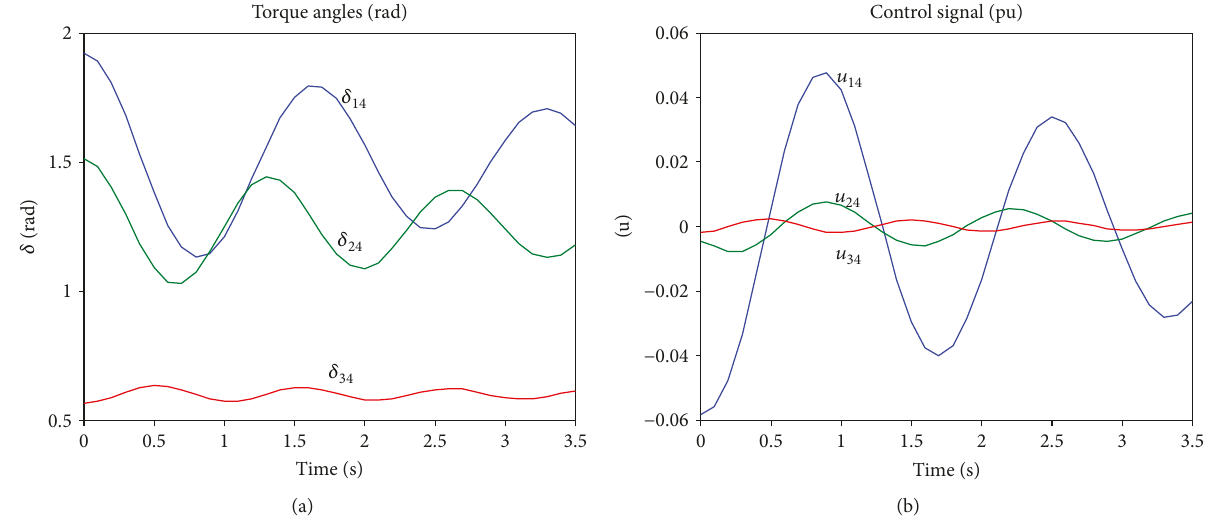
Figure 4: Rotor angle and control signals for decentralized H